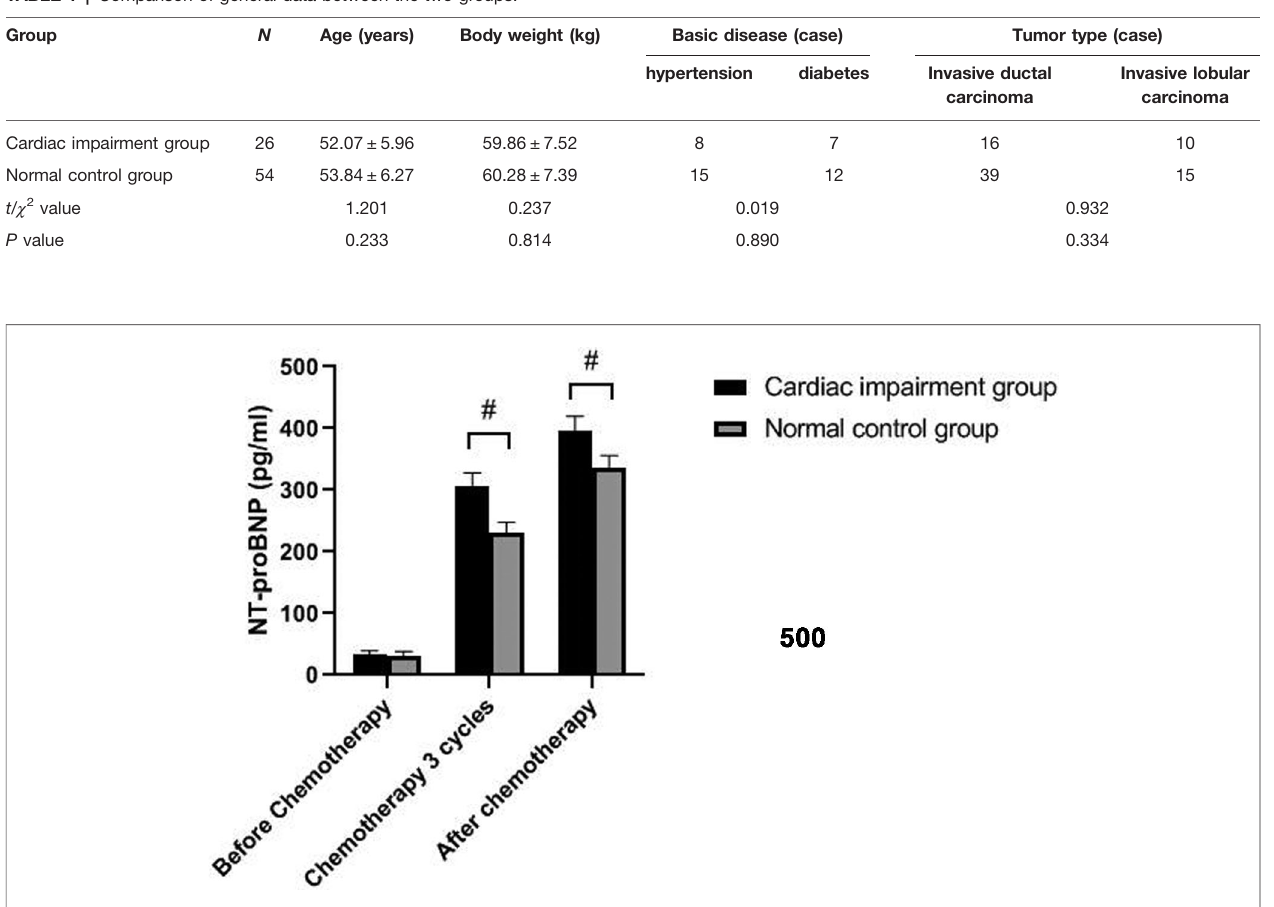
FIGURE 1 | Comparison of NT-proBNP levels in two groups of patients at different time points. Note: Compared with the normal control group, # P